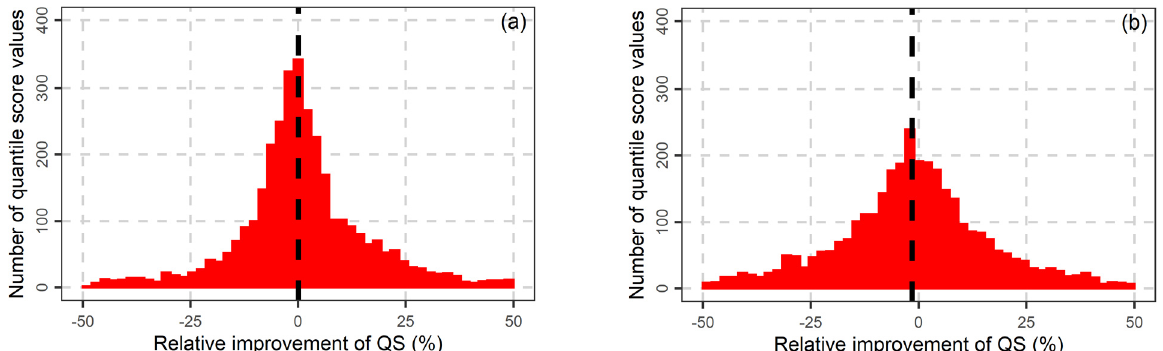
Figure 5. Histograms of the relative improvements (with red colour) and the median values of these relative improvements (with black dashed lines) against the performance of the GR4J hydrological model in terms of quantile score, as computed for all the 511 river basins and the 0.025, 0.050, 0.100, 0.500, 0.900, 0.950, 0.975 quantile levels, for the ( a ) GR5J and ( b ) GR6J hydrological models. Truncation at –50% and 50% has been applied for illustration purposes.